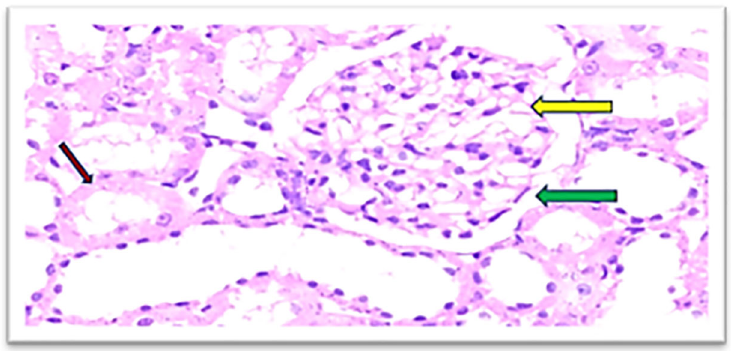
Figure 7. Section of the kidney tissue of rat treated Cyanocobalamin for 14 days (Group III) show A normal glomerulus (yellow arrow) and the urinary space is within normal limits (Green arrow), the interstitial shows no congestion (Pink arrow) (H&E, (cid:1) ofthe pelvicalyceal system Figure 8c,moderate infiltrate ofinflammatory cells of the interstitial Figure 8das shownin the Extended data. 39 Group V showed a moderate increase in urinary space, moderate congestion of glomeruli and interstitial as shown in Figure 9A, moderate amount of hyaline cast in the tubular lumen and degeneration as shown in Figure 9B, moderate inflammation ofthepelvicalyceal system 9C,moderate inflammatory cellinfiltrate ofinterstitial as showninFigure 9Das shown in the Extended data. 39